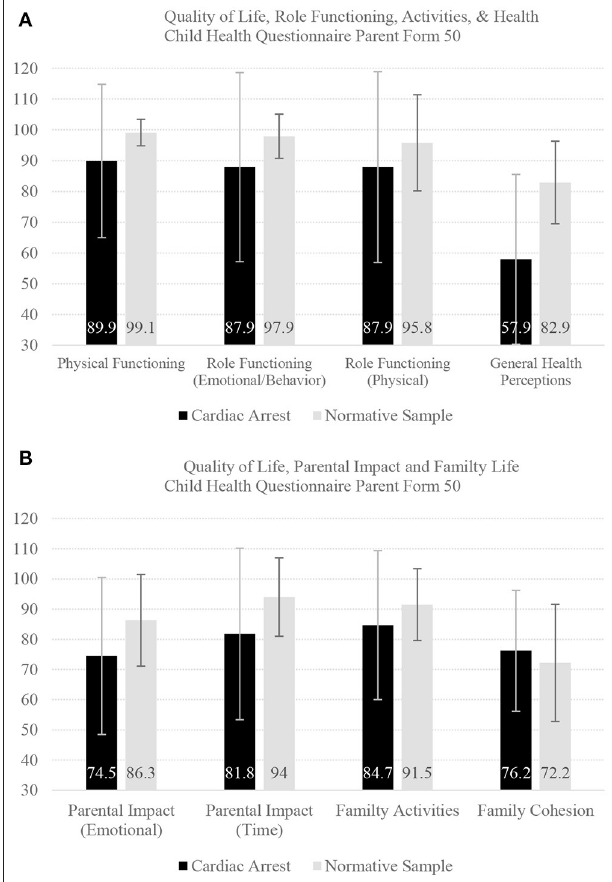
FIGURE 4 | Quality of life outcomes in children and adolescents. There were 33 children and adolescents followed a median of 5.6 years following either in hospital or out of hospital cardiac arrest using the Child Health Questionnaire ( 53). They were compared to 353 youth in a normative sample. The bars represent mean scores and the error lines represent the standard deviation. Child Health Questionnaire Parent Form 50 Questions, differences between groups in Cohen’s d effect sizes: Physical Functioning (Cohen’s d = 1.11): limitations in playing sports, recreational activities, walking, or self care; Role Functioning (Emotional/Behavior Limitations) (d = 0.89): school work or social life limited by emotional or behavioral difficulties; Role Functioning (Physical Limitations) (d = 0.45): school work or social life limited by physical health problems; General Health Perceptions (d = 1.66): child seems less healthy than other children; Parental Impact (Emotional) (d = 0.72): parental emotional concern about child; Parental Impact (Time) (d = 0.82): parents being limited in the amount of time for their own needs because of child; Family Activities (d = 0.51): child’s health or behavior limits family activities; and Family Cohesion (d = 0.21): family’s ability to get along with one another. This figure uses mean scores and standard deviations presented in Van Zellem et al.